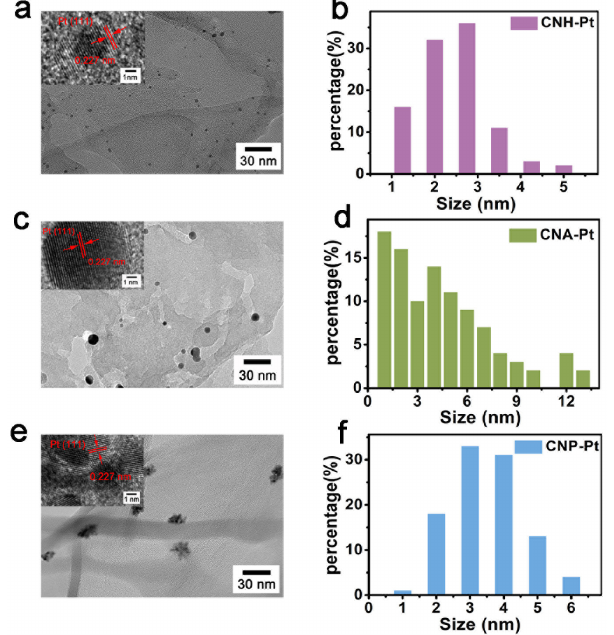
Figure 2. TEM images and Pt NPs size distribution of CNH-Pt ( a , b ), CNA-Pt ( c , d ), and CNP-Pt ( e , f ). Insets show HRTEM images of CNH-Pt ( a ), CNA-Pt ( c ), and CNP-Pt ( e ).